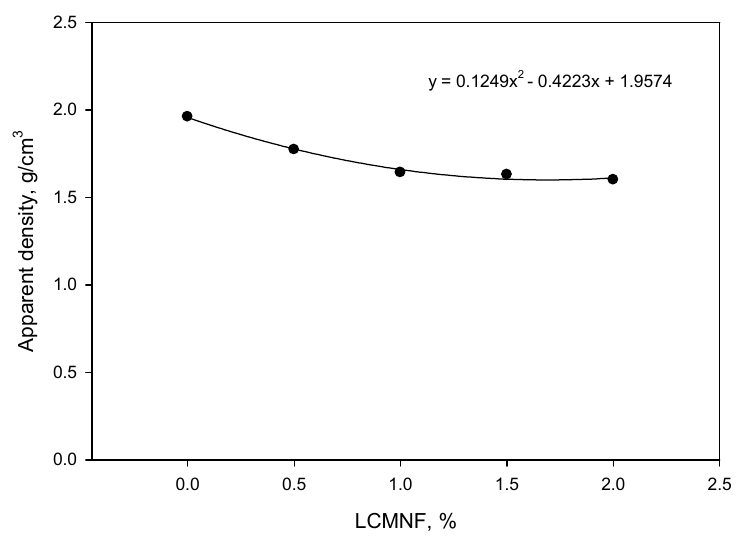
Figure 2. Evolution of apparent density of dried cement-based composites as the amount of LCMNF was increased.